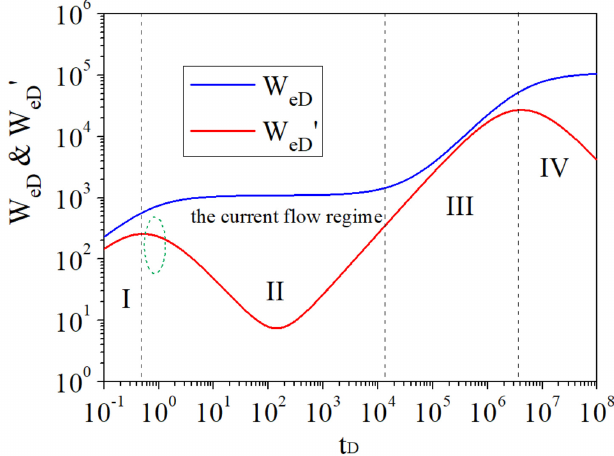
Figure 13. Dimensionless water invasion characteristic curves of gas reservoir Z1. Regime I is fracture radial flow. Regime II is cross flow caused by matrix supply. Regime III is transitional radial flow. Regime IV is pseudo-steady flow.